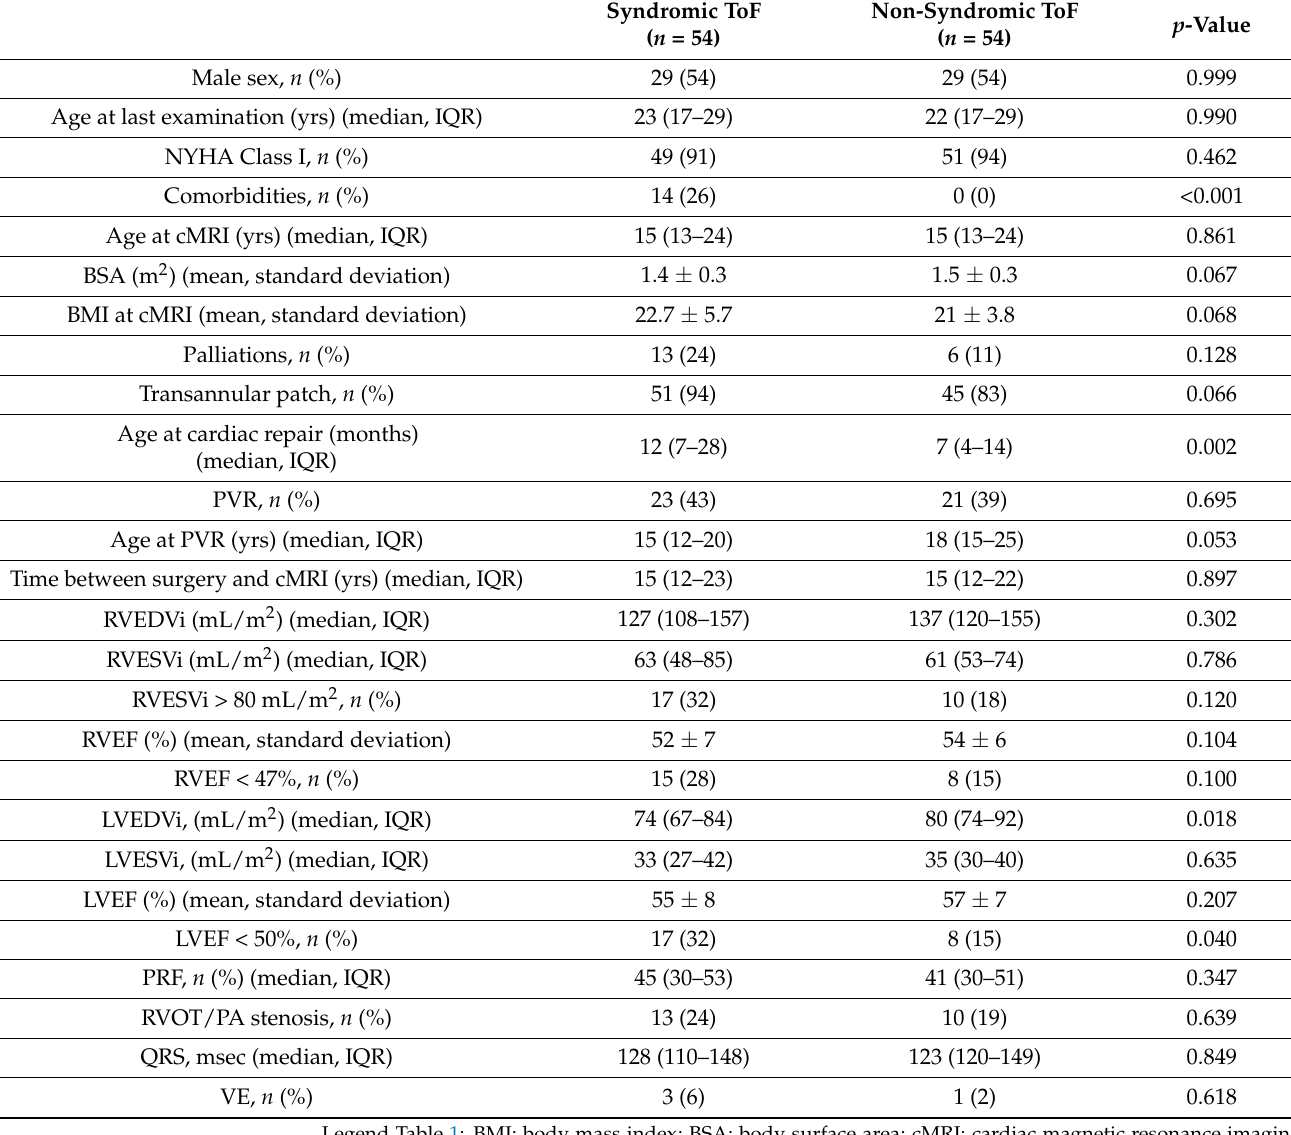
Table 1. Clinical, ECG and cMRI characteristics according to the presence of a genetic syndrome.